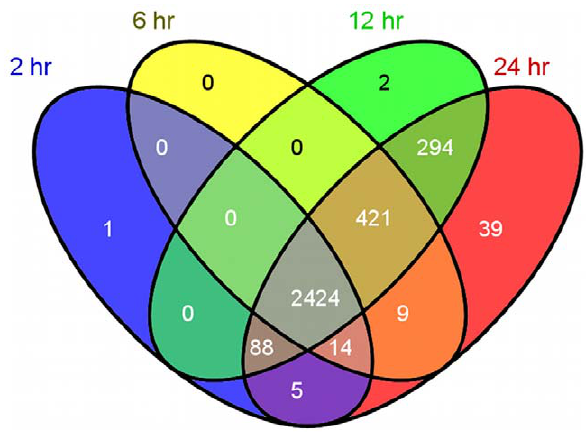
Figure 7. Unique Asexual Stage Gene Expression. Gene transcription fluctuates during the infection time course. Most genes are detected at all 4 time points within the first 24 hours of infection (asexual replication). Gene lists were constructed containing the gene IDs for all genes with detectable transcription (non-zero) at 2, 6, 12, and 24 hr time points. These lists were compared to show the number of genes with overlapping expression at all combination of the four time points used. Blue=2 hr, yellow=6 hr, green=12 hr, and red=24